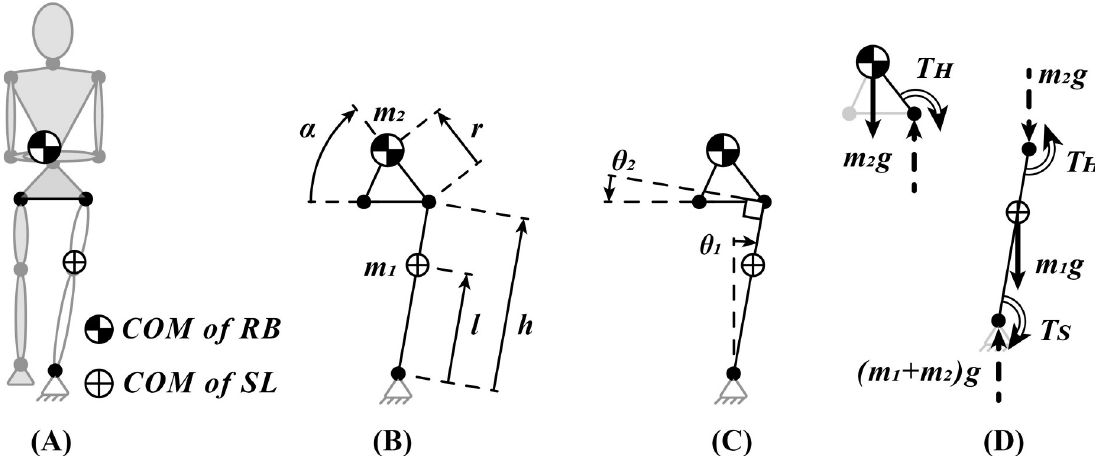
Fig 1. Details of the double inverted pendulum model used to represent the task of balancing on one leg in the frontal plane over a stationary stance foot. (A) One link represents the stance leg (SL) and the other the rest of the body (RB). The trunk is assumed to be straight without any lateral bending, and the contralateral leg is kept at a neutral abduction angle. (B) Parameters of the model are calculated from published mass-link information of a mid-size male aviator (m 1 = 14 Kg, m 2 = 67 Kg, l = 57 cm, h = 88 cm, r = 19 cm, α = , θ are required to describe balancing quasistatically on one leg. (D) Free Body Diagram for the 56˚) [29]. (C) Two independent states (θ 1 2 ) equilibrium of the quasistatic double inverted